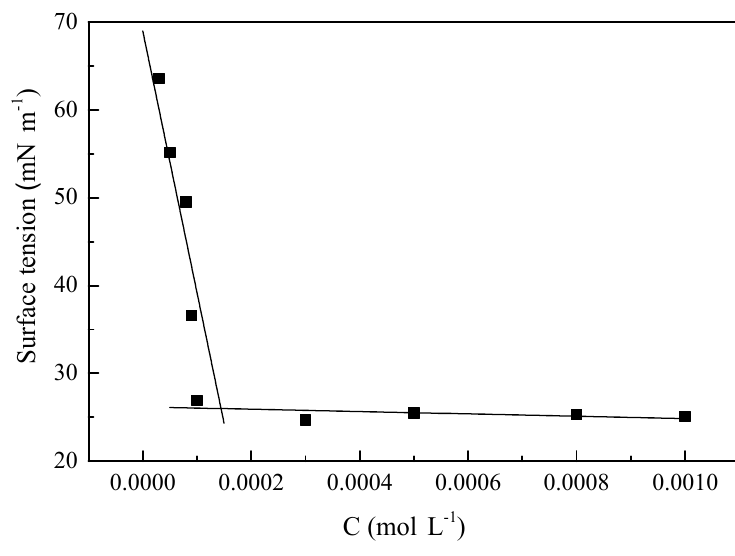
Figure 3. Surface tension plot for VES-T tri-cationic surfactant.